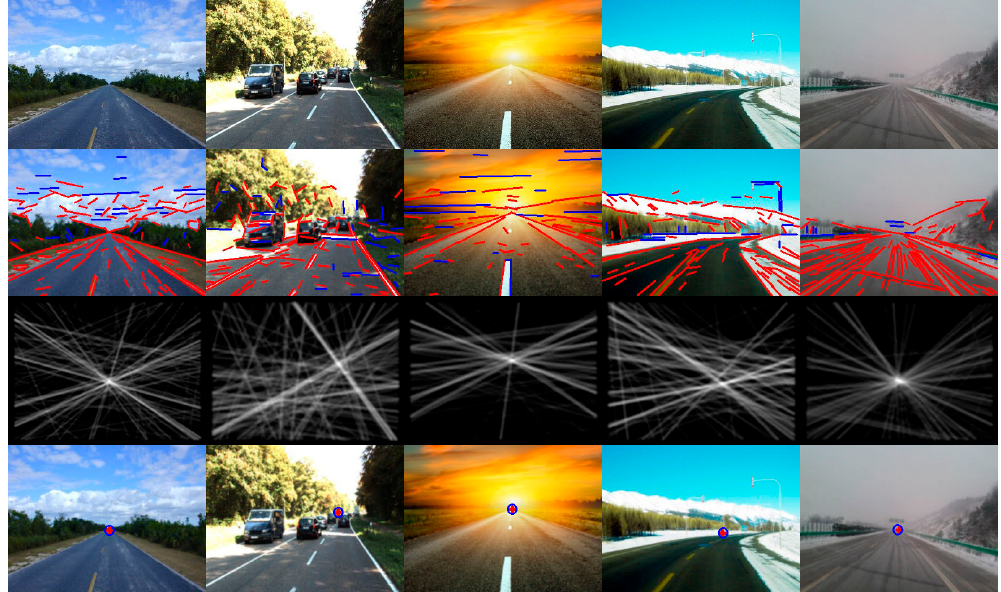
Figure 8. Vanishing point detection and road segmentation examples for structured roads using the study’s proposed method. The first row images are the input images. The second row images are the detected line segments. The third row images are the line space voting images. The fourth row images show the estimated VPs and the ground truth (the red cross is the estimated VP location; the blue circle is the ground truth).